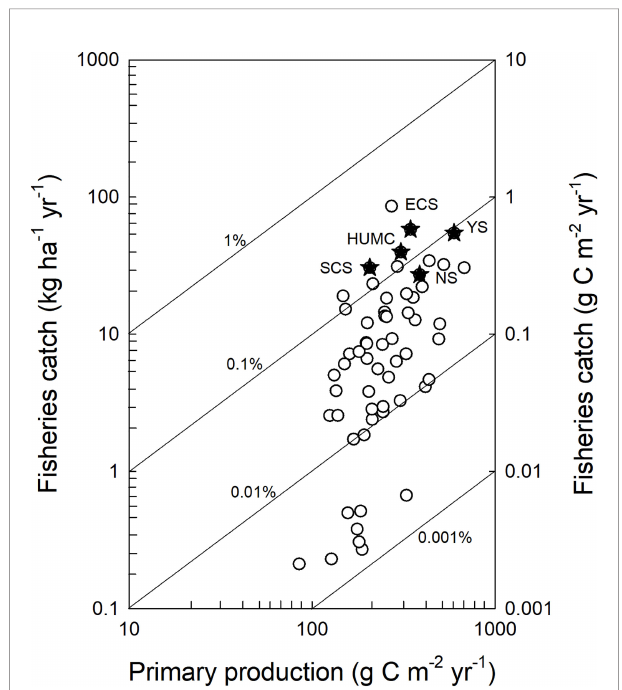
FIGURE 2 | Relationships between primary production and fi sheries catch in the 63 large marine ecosystems (LMEs) in 2018 based on the data from SAU. The asterisks indicate the South China Sea (SCS), Humboldt Current (HUMC), East China Sea (ECS), North Sea (NS), and Yellow Sea (YS). The diagonal lines and associated % values show different levels of ef fi ciency in carbon transfer from primary production to fi sheries catch [carbon transfer ef fi ciency